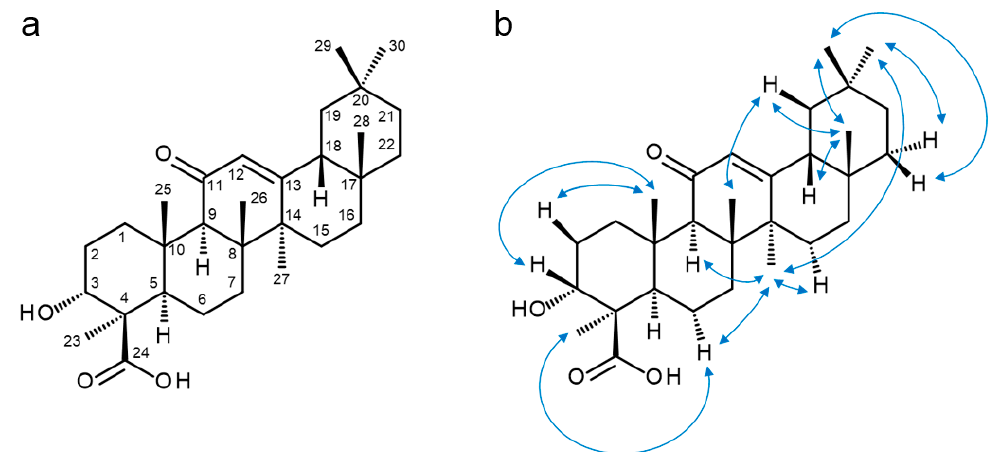
Figure 3. Chemical structure of 11-keto- α -boswellic acid ( α -KBA). ( a ) Structure and numbering scheme. ( b ) Illustration of important ROESY (rotating frame Overhauser enhancement spectroscopy) correlations. Table 1. 1 H and 13 C NMR (proton and carbon-13 nuclear magnetic resonance) assignments for 11-